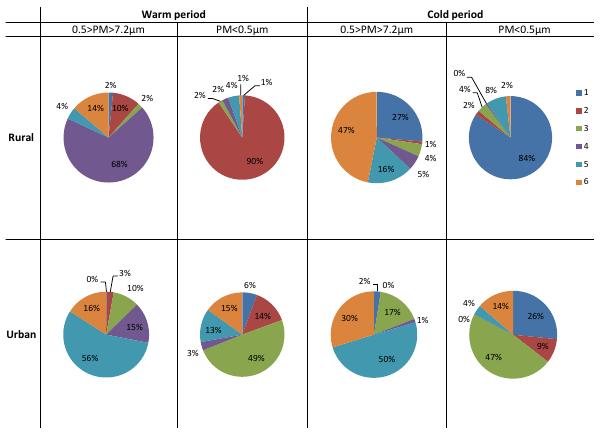
Figure 7. Relative scores of the components (%) in rural and urban site in relation to the warm and cold period: (1) combustion POA, (2) vegetation POA, (3) urban POA, (4) aged SOA, (5) soil POA and (6) fresh